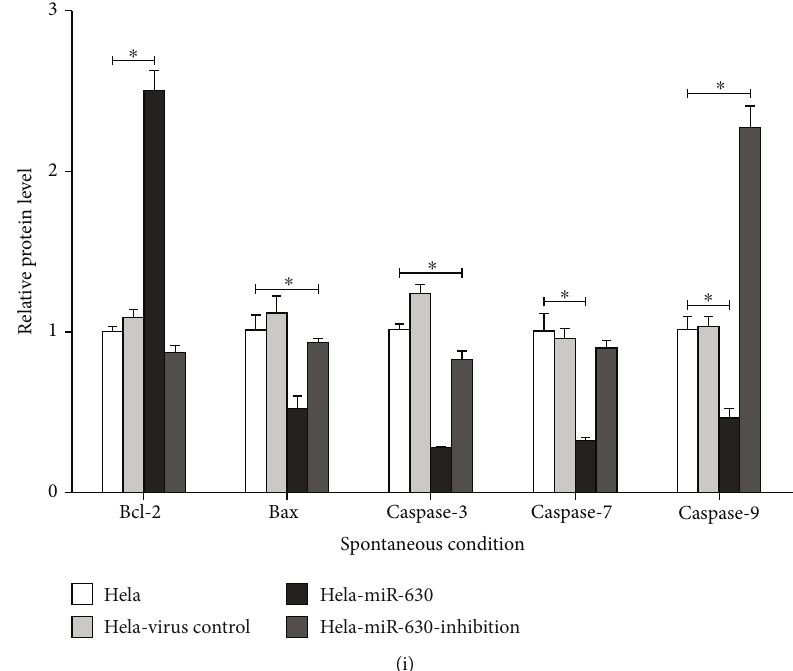
Figure 5: miR-630 increases the radioresistance and signi fi cantly reduces the apoptosis level of HeLa cells under spontaneous and radiation- treated conditions. (a) RT-qPCR analysis of lentiviral overexpression and inhibition of miR-630 in HeLa cell lines. (b) Colony formation assay showing the higher radioresistance by miR-630 overexpression and opposite phenotype by miR-630 inhibition. ∗ p < 0 : 05 . (c, d) Overexpression of miR-630 increased the cell proliferation rates of HeLa cells under irradiation conditions. (e) miR-630 overexpression reduced the spontaneous apoptosis levels of HeLa cells. (f, g) miR-630 overexpression reduced the radiation-induced apoptosis levels of HeLa cells. (h) Western blotting showing the expression changes of several apoptosis markers in HeLa cells with miR-630 overexpression or inhibition under radiation-treated conditions. (i) Western blotting showing the expression changes of several apoptosis markers in HeLa cells with miR-630 overexpression or inhibition under spontaneous